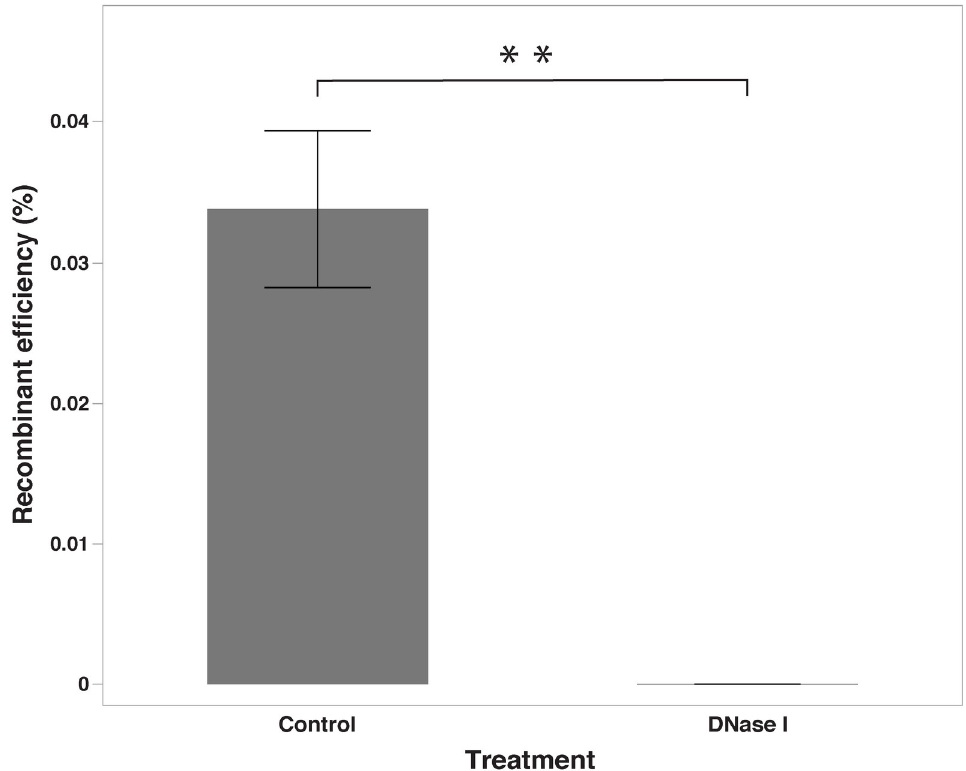
Fig 9. Changes in recombinant levels after addition of DNAse I (DNase I). Recombinant levels were compared when the recombination assay was performed without (control) and with the addition of DNAse I (DNase I) to eliminate extracellular DNA from the medium. Recombinant levels expressed as percentage recombinants in the total number of parent cells; �� indicates a significant difference at P < 0.01.